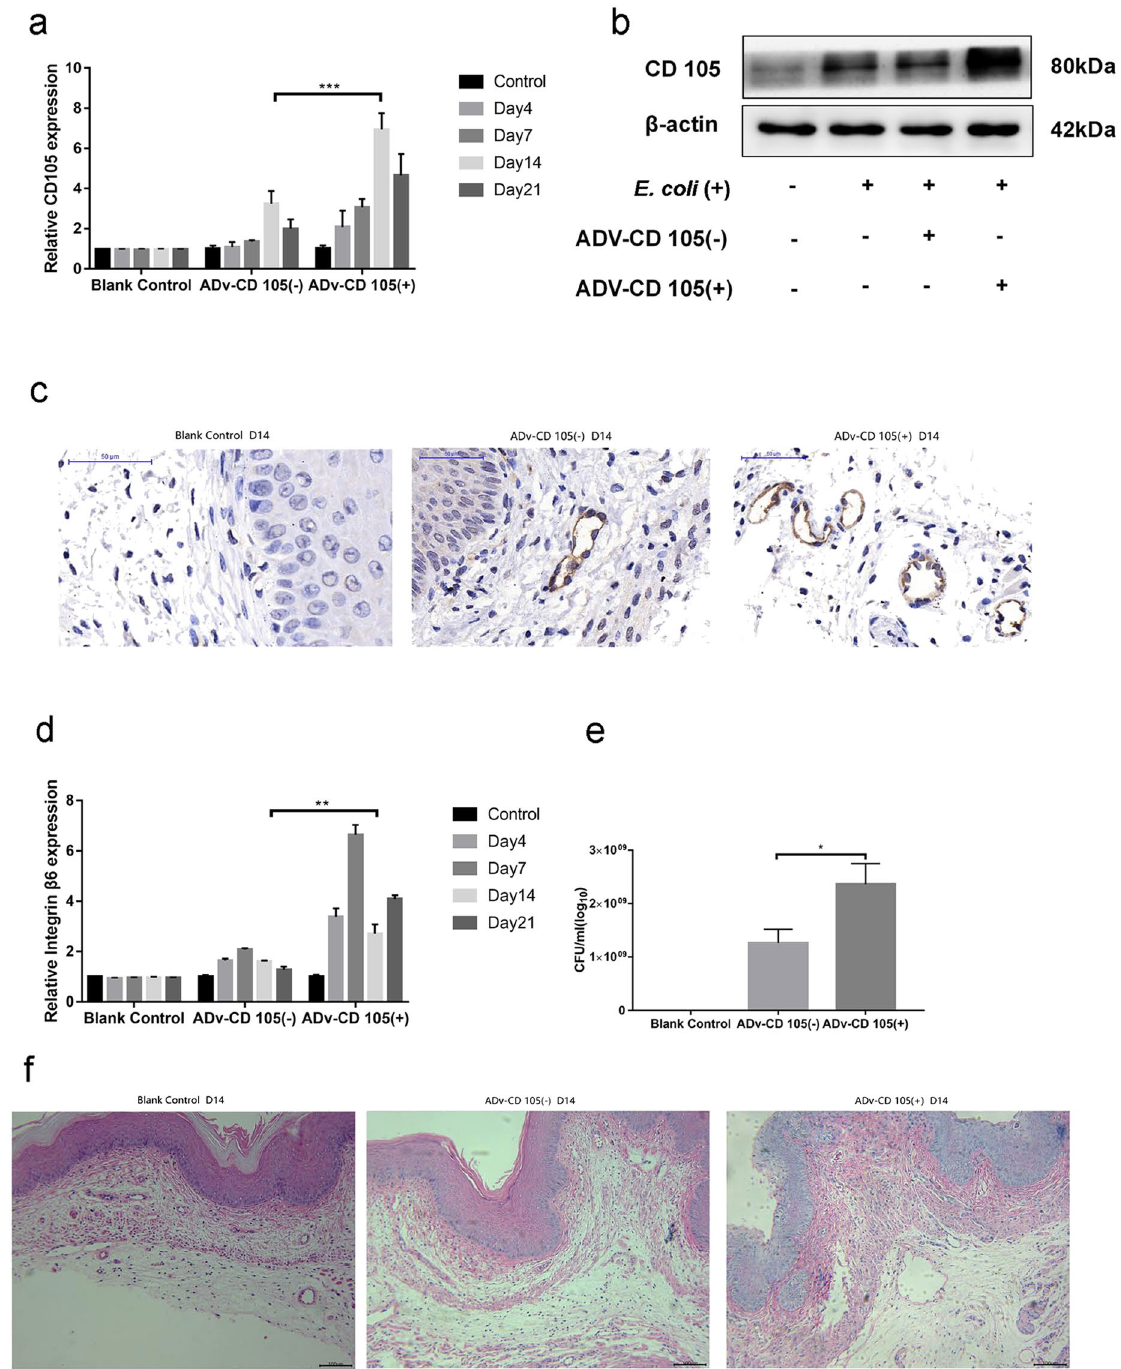
Figure 5. Overexpression of CD105 exacerbated vaginal infection in mice. ( a ) Administration of the CD105 overexpression adenoviral vector increased the mRNA expression level of CD105 in the vaginal tissue of mice; ( b ) CD105 overexpression increased the protein expression of CD105; ( c ) The change in CD105 protein expression after administration of the CD105 overexpression adenoviral vector was shown by immunohistochemical staining; ( d ) Administration of the CD105 adenoviral vector enhanced the mRNA level of integrin α v β 6; ( e ) The total number of vaginal microbes was also increased; ( f ) Haematoxylin-eosin staining showed that overexpression of CD105 exacerbated vaginal infection in mice. * P < 0.05, ** P < 0.01, compared with the control group; * P < 0.05, ** P < 0.01, compared with the E. coli infection